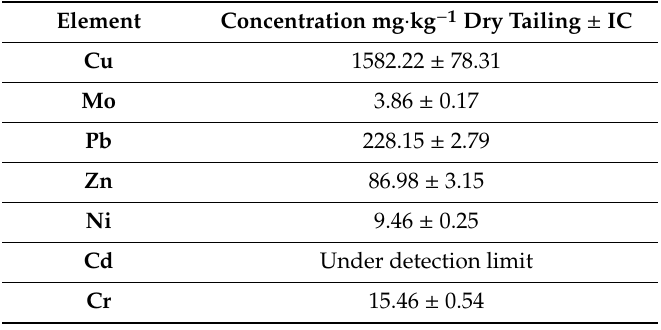
Table 2. Initial concentration of Mo, Cu and Pb in dry tailing ± confidence interval (IC).